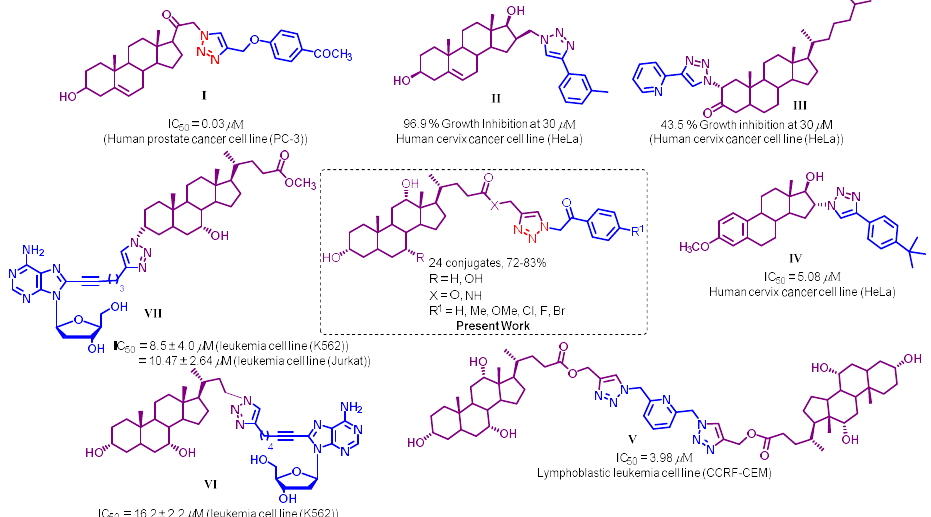
Figure 1. Representative examples of triazole-derived steroids and bile acids as anticancer agents.